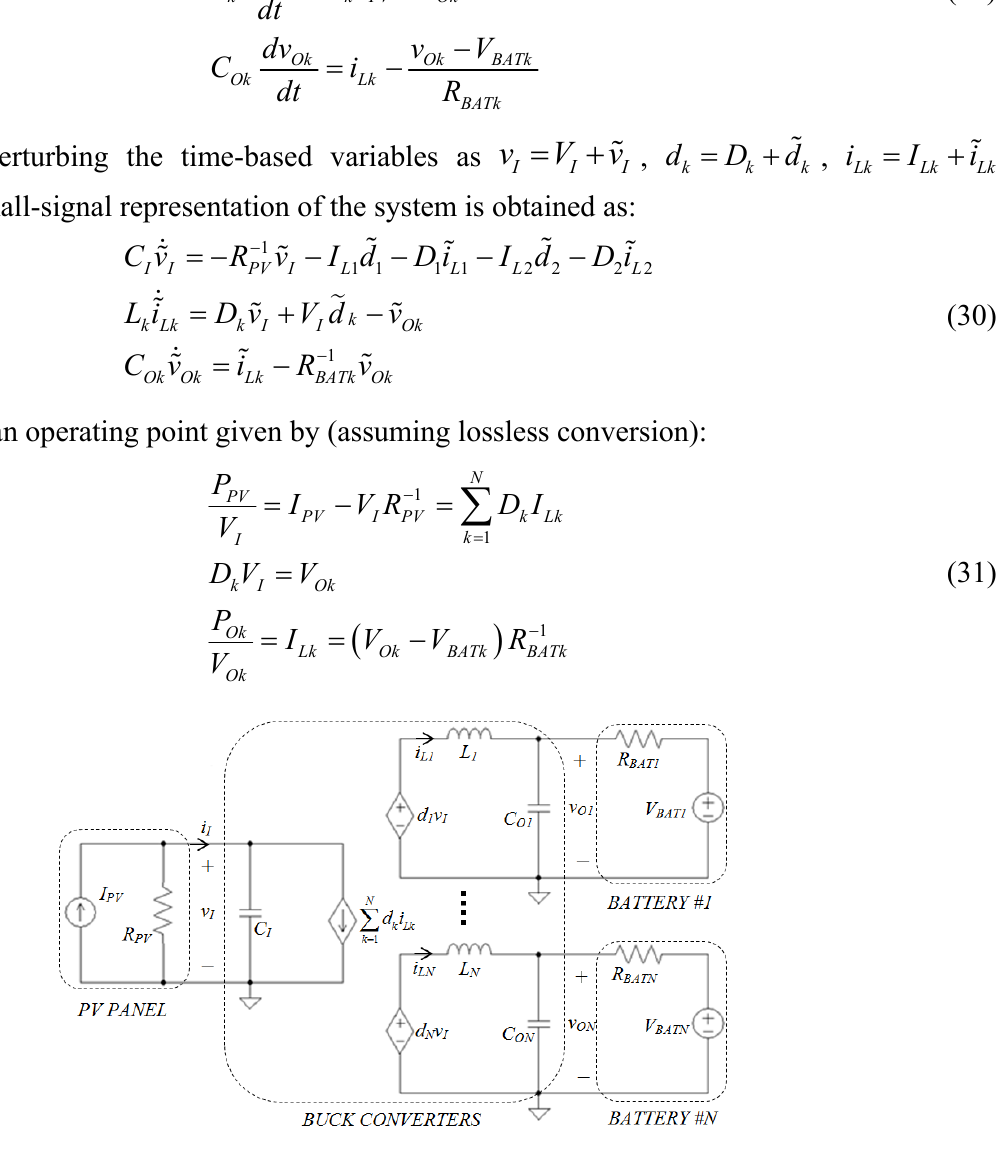
Figure 15. Large-signal system